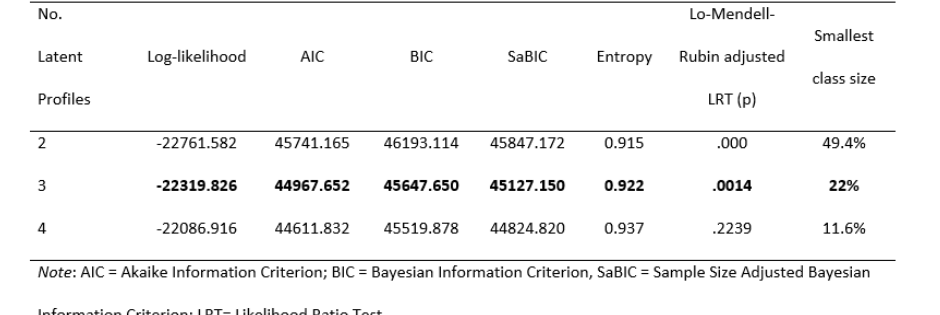
Table 1. Fit statistics for the